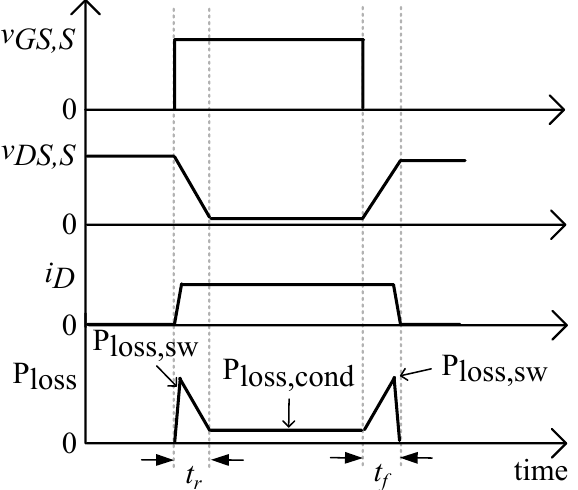
Figure 12. Conduction and switching losses wave